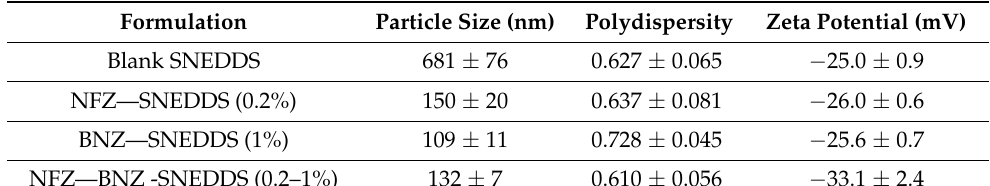
Table 3. Mean particle size, polydispersity, and zeta potential of prepared batches of blank and drug-loaded SNEDDS ( n = 3).